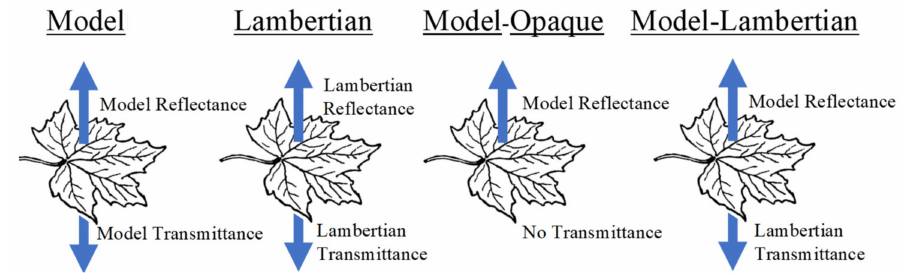
Figure 11. Visualization of the four di ff erent leaf BSDF configurations used for the sensitivity studies.